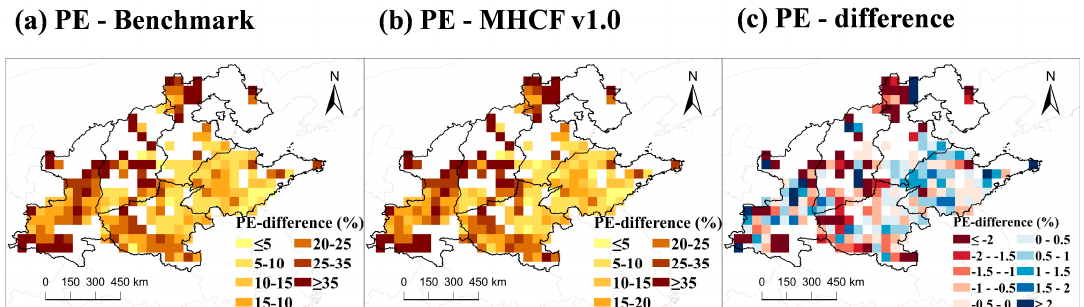
Figure 9. Spatial patterns of the mean PE for XGBoost. ( a ) PE calculated by Benchmark model using XGBoost; ( b ) PE calculated by MHCF v1.0 using XGBoost; ( c ) PE difference between ( a , b ) (former minus the latter). Positive values indicate that the Benchmark model has a greater error, while negative values indicate that the MHCF v1.0 model has a greater error.